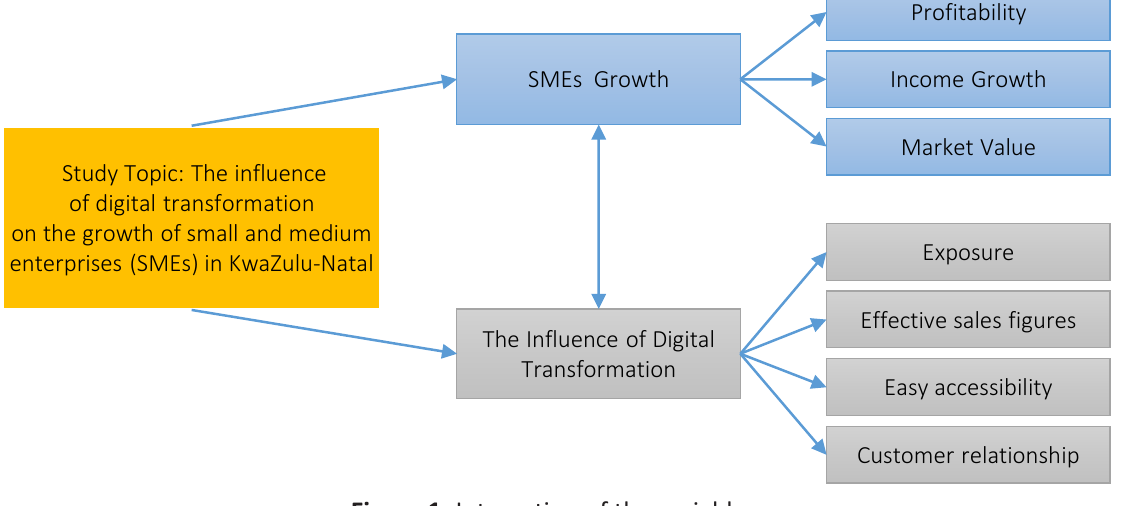
Figure 1. Interaction of the